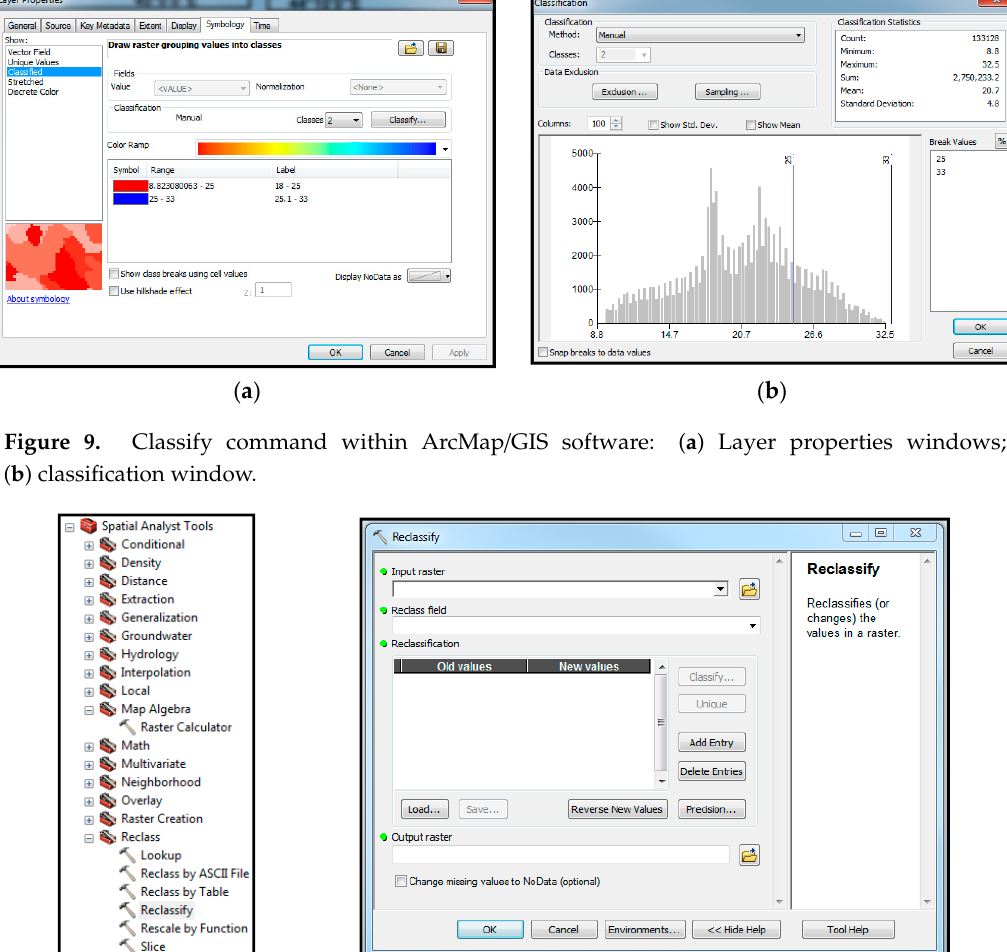
Figure 7 . Transmissivity maps (ranges and rates).